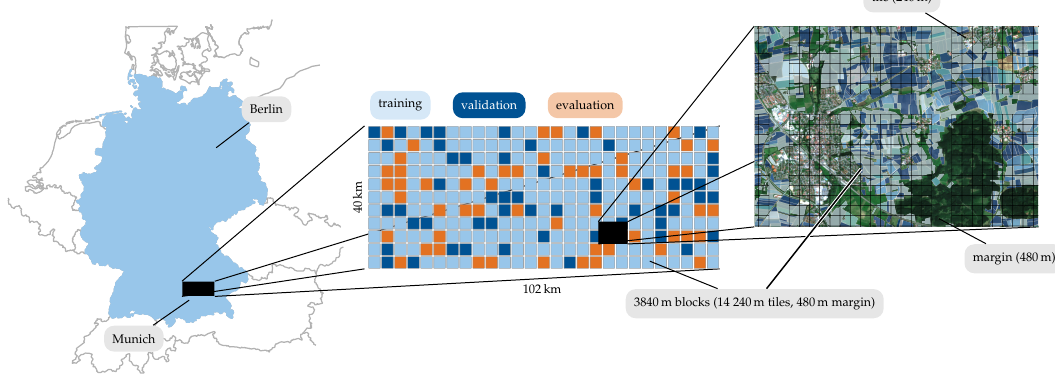
Figure 4. Area of interest (AOI) north of Munich containing 430kha and 137k field parcels. The AOI is further tiled at multiple scales into datasets for training, validation and evaluation and footprints of individual samples.